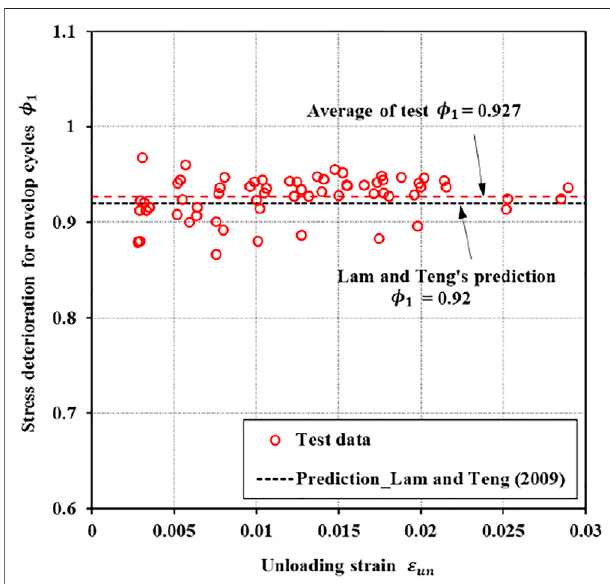
FIGURE 12 | Comparisons of the stress deterioration factor of the fi rst cycle ϕ 1